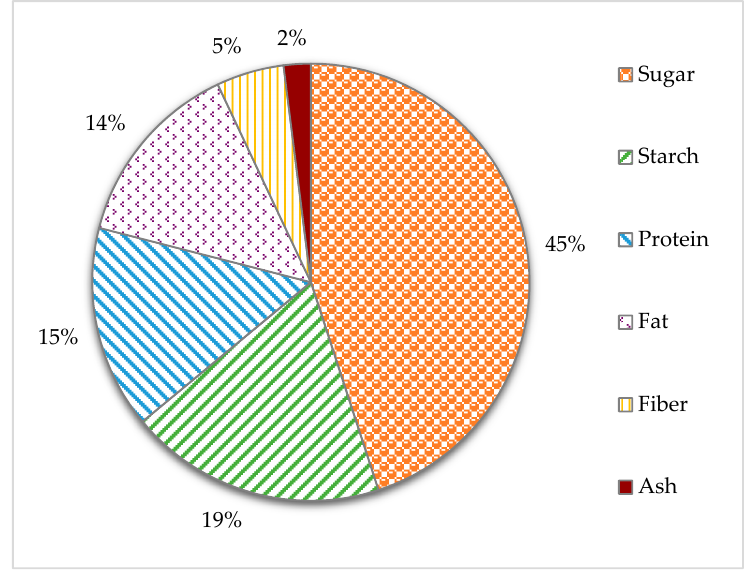
Figure 1. Average values of food waste (FW) composition (% w / w , wet basis) [17–21].